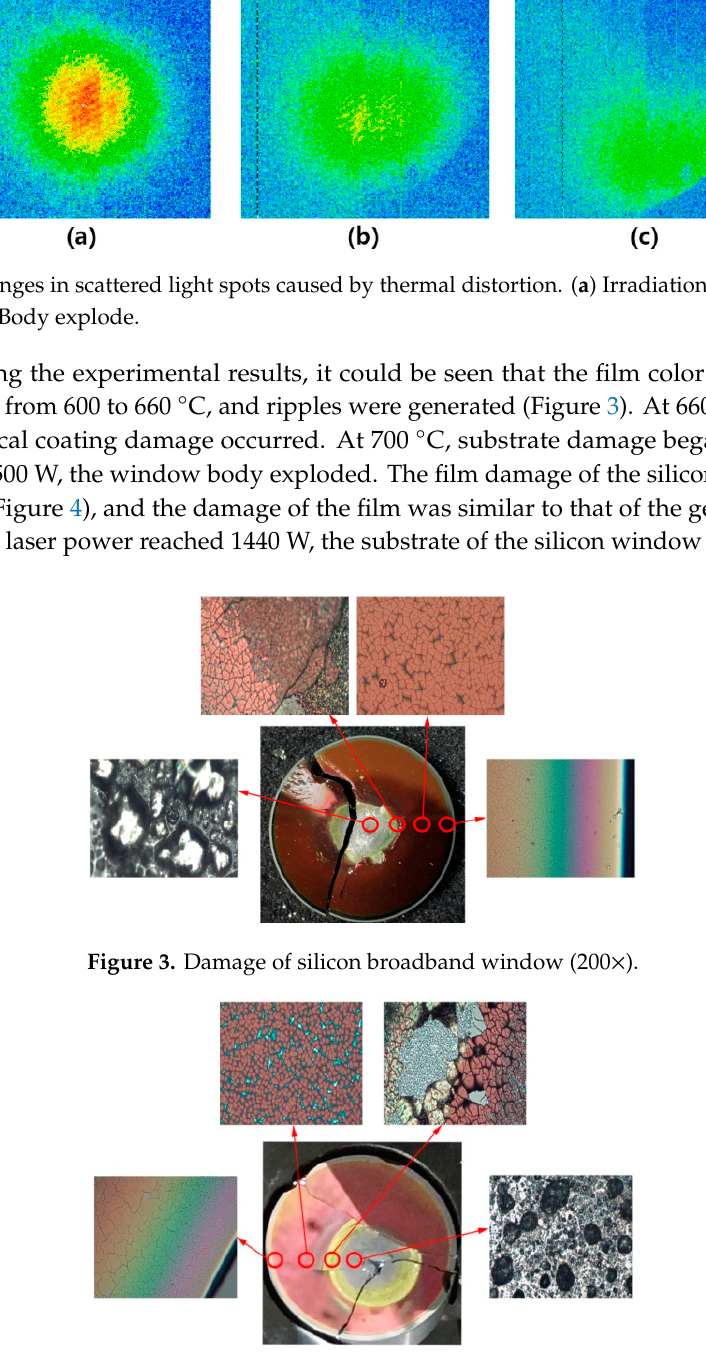
Figure 4. Damage of germanium broadband window (200×) .